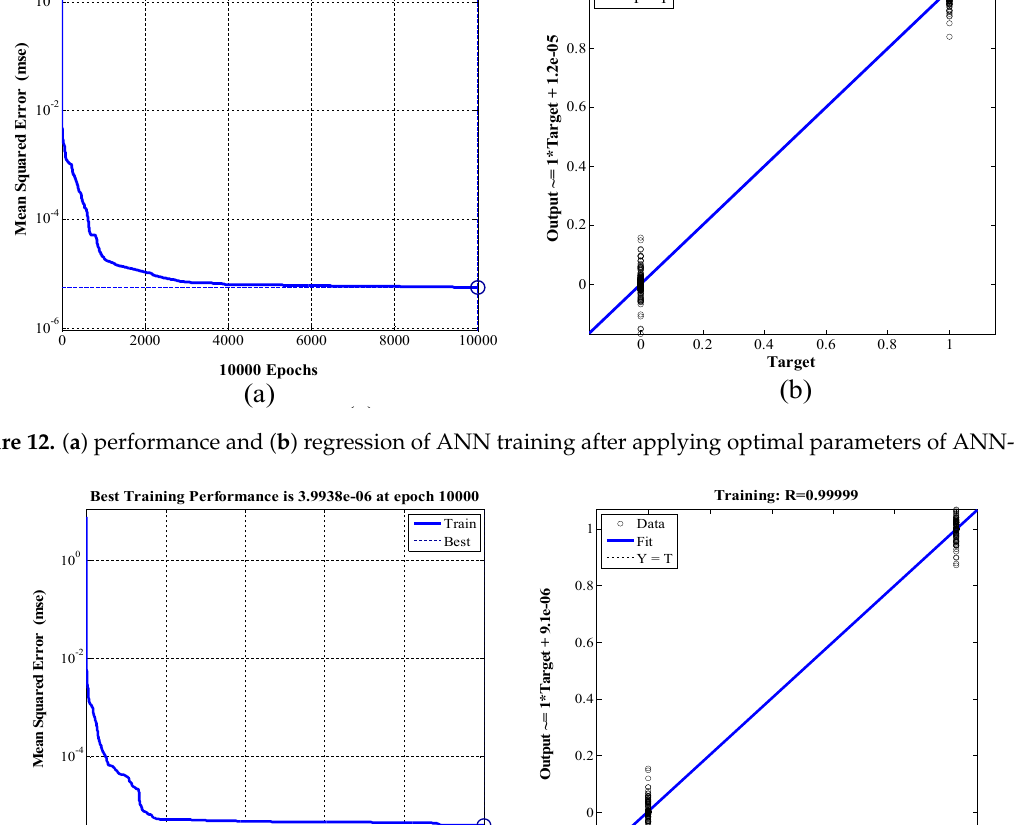
29 of 43 Figure 11. ( a ) Performance and ( b ) regression of ANN training after applying optimal parameters of ANN-BSA. However, other optimization techniques trained for 10,000 epochs on their optimal pa- rameter have good results somewhat near in results. However, in Figure 12, ANN-GA shows the best training performance of 5.4579 × 10 −6 , and regression (R) reach 0.99999 it is very close to unity. Figure 13 and Figure 14 show the best training performance of 3.9938 × 10 −6 and 2.5178 × 10 −5 and regression of 0.99999 and 0.99995 for ANN-PSO and ANN-ABC [210]. Fair comparison results of Bus1 of 14-bus IEEE test system for virtual power plants utilize the optimized ANN net based on half-hour binary patterns for managing each dis- tributed generation (DG) unit in the system. The binary (ANN-BPSO), binary (ANN- BABC), binary ANN-BGA, and binary (ANN-BBSA) is a controller with binary output 0